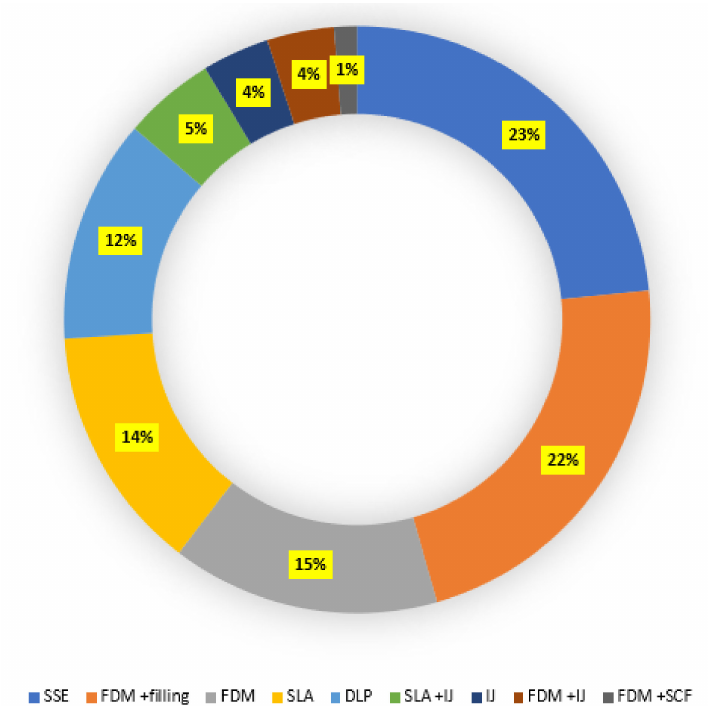
Figure 5. 3DP techniques used in the articles included in the systematic review (IJ, inkjet; SCF, supercritical fluid